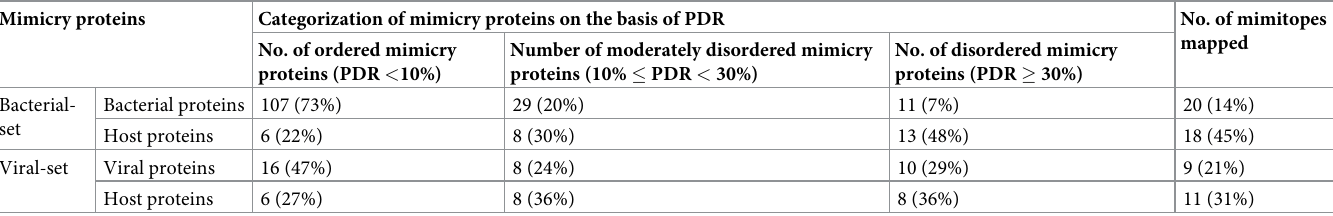
Table 1. Categorization of mimicry proteins of pathogens and hosts on the basis of PDR (percentage of disordered residues in protein). Mimicry proteins